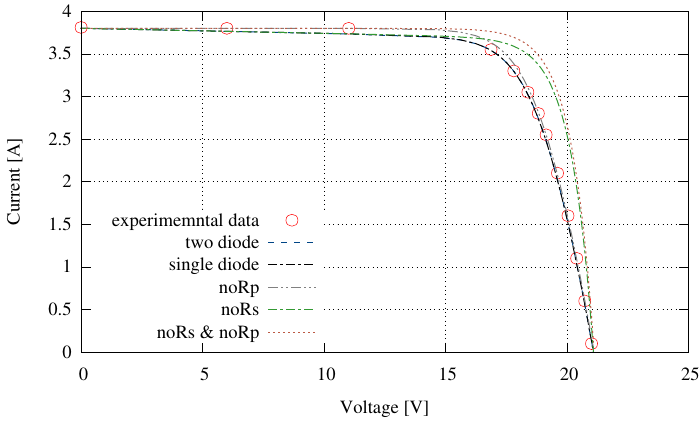
Figure 3. Results of model tuning for Solarex MSX60 PV module.